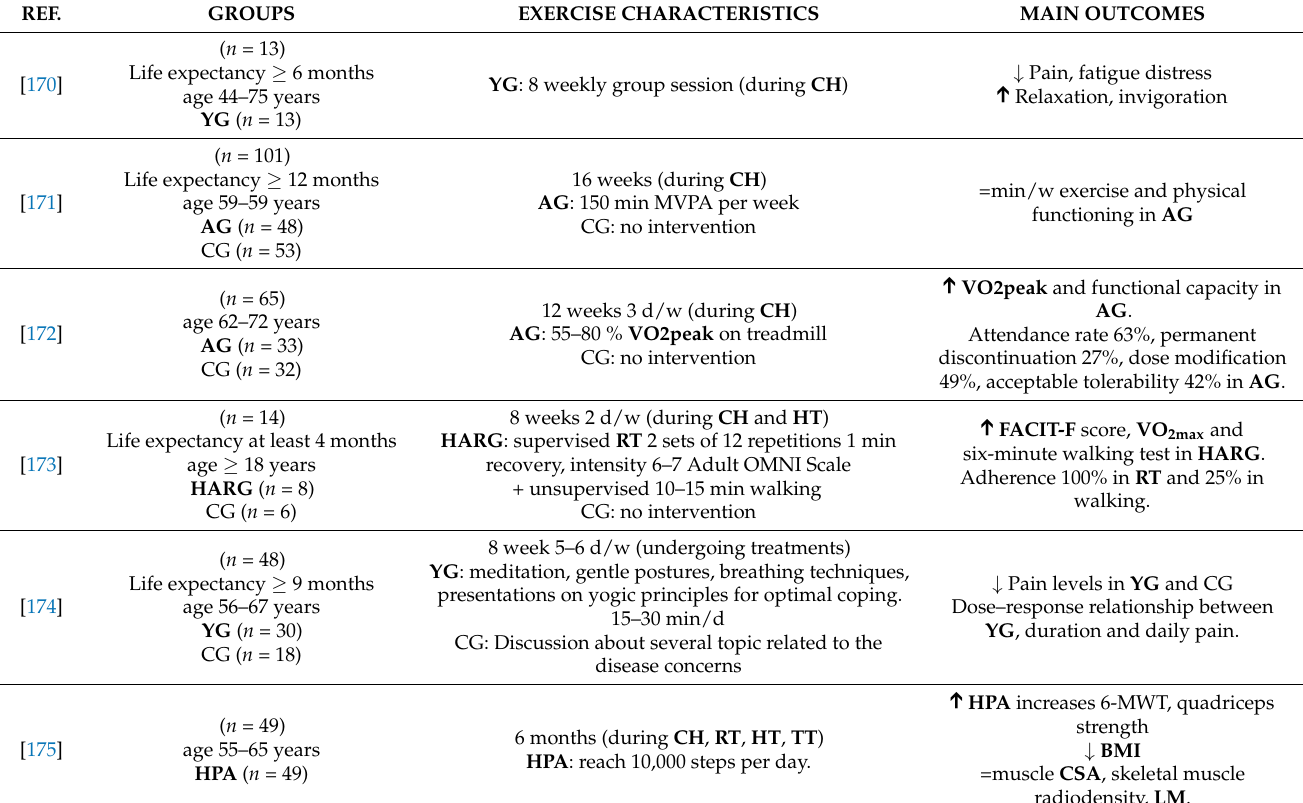
Table 4. Exercise and physical activity as quaternary prevention in advanced-stage breast cancer patients.